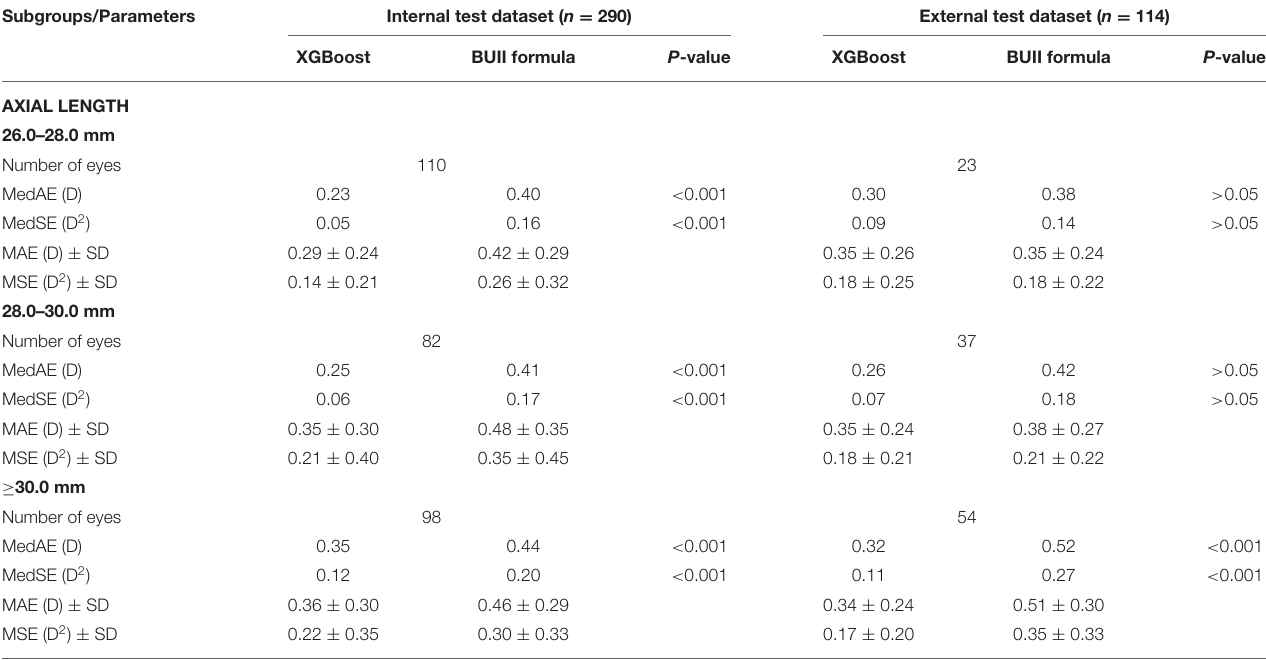
TABLE 4 | Summary of outcomes from axial length subgroup analyses comparing the XGBoost calculator and the Barrett Universal II formula in the internal and external test datasets.